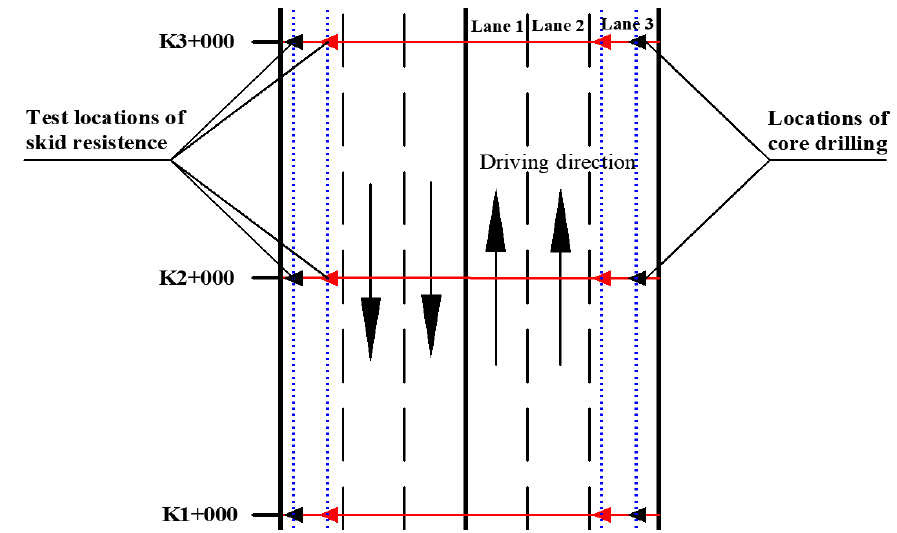
Figure 2. Schematic diagram of the test locations of skid resistance and core drilling.